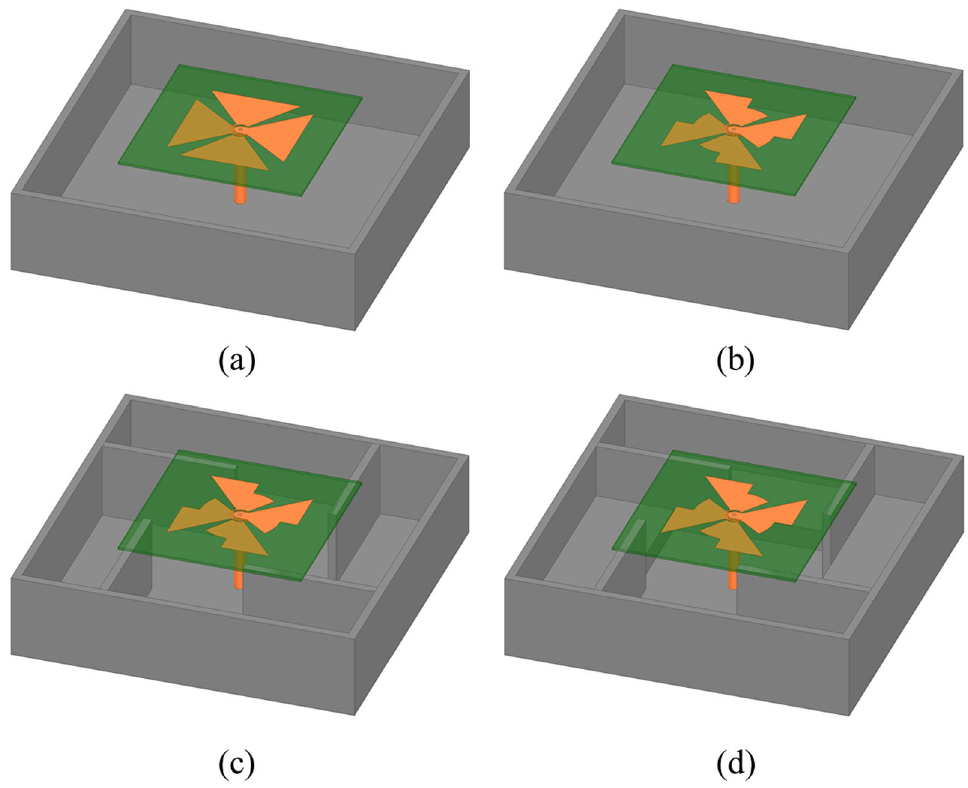
Figure 2. Evolution of the proposed CP antenna. ( a ) Ant.1. ( b ) Ant.2. ( c ) Ant.3. ( d )